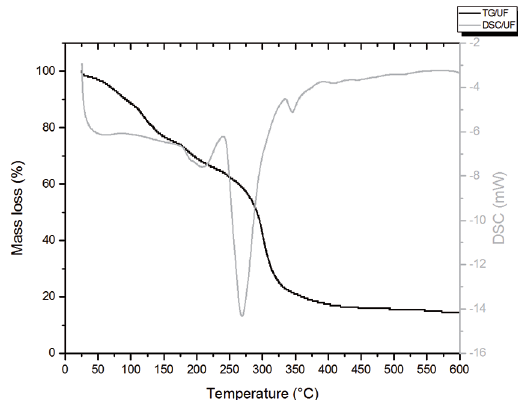
Figure 1: Mass loss of the urea formaldehyde adhesive as a function of temperature. On evaluating the IE2h property, only those panels treated at 250°C and 5 min showed no statistical difference from the panels without heat treatment. Treatments at temperatures of 200 and 225°C at both times (5 and 10 minutes) reduced IE2h, ranging from -43.5 to -87.1%. While the treatment at 250°C for 10 minutes time, also differed statistically